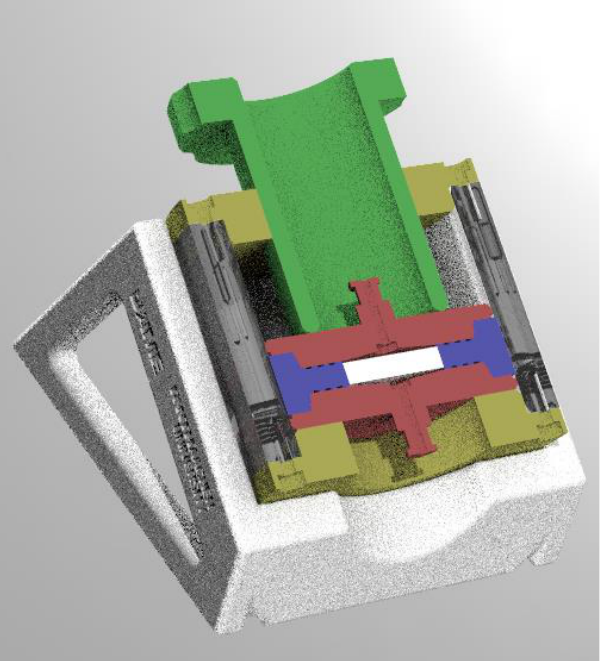
Figure 2. CAD sketch of a RatOx oxygenator on a pedestal. White: Size-variable fiber mat; blue: Silicone potted around the fiber mat, forming a fiber bundle; red: Top and bottom cap with connector for circuit tubing; dark gray: cylindrical transparent housing; yellow: Outer caps; green: Screw to secure all components with varying fiber module